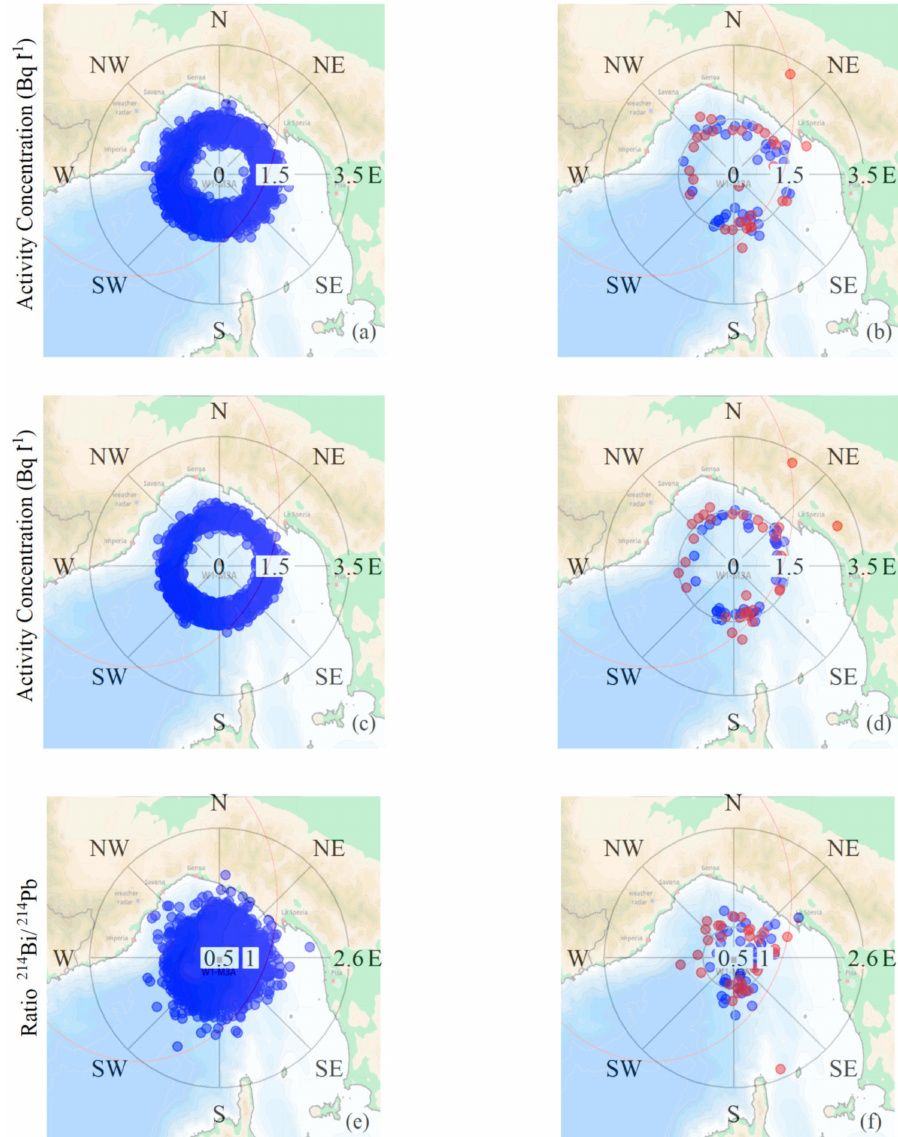
Figure 6. Wind direction analysis of activity concentration values of 214 Pb ( a , b ), 214 Bi ( c , d ) and the ratio 214 Bi/ 214 Pb ( e , f ), during dry meteorological conditions in the first column and during rainfalls in the second. The events of statistically significant variation of TCR are presented with red